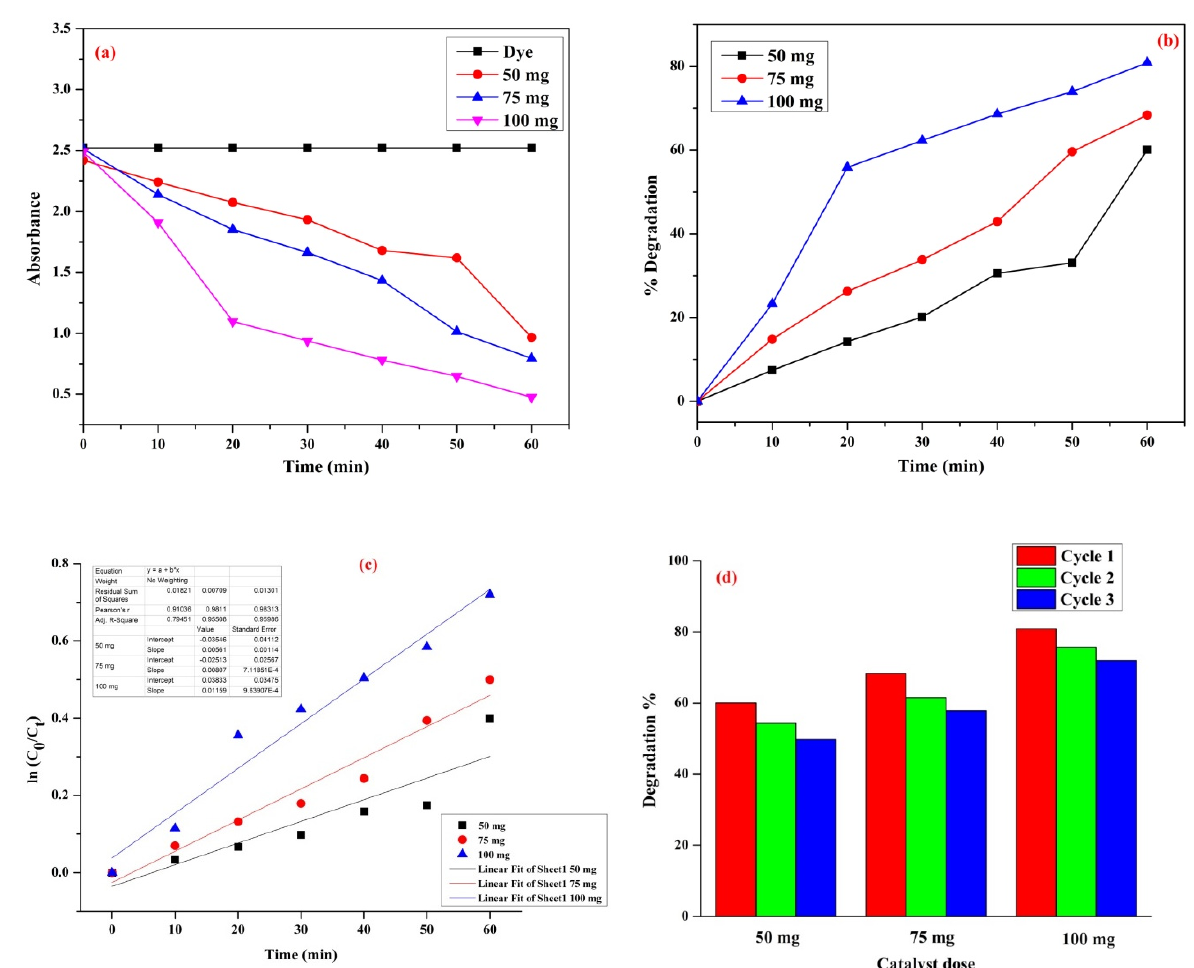
Figure 5. ( a ) Plot of time vs. absorbance, ( b ) plot of time vs. % Degradation, ( c ) linear regression graph of MB degradation using different catalyst weights, and ( d ) plot for number of cycles using different catalyst doses vs. % degradation.